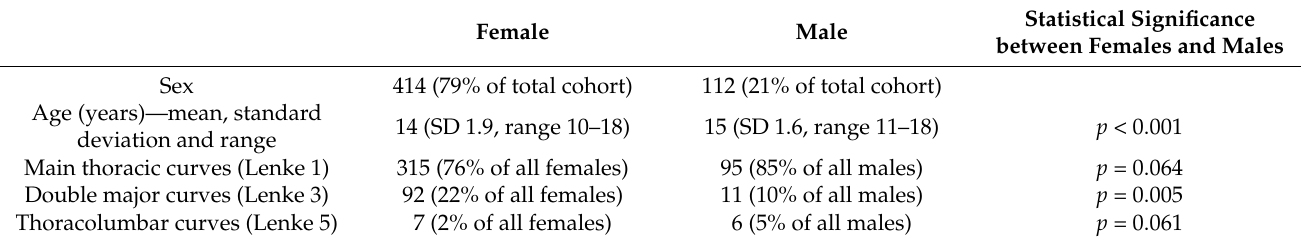
Table 1. The demographics of the cohort.